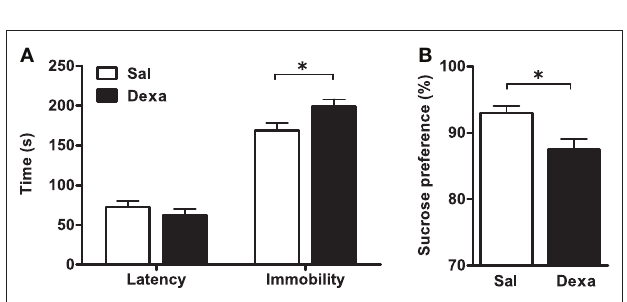
FIgure 2 | Prenatal administration of dexamethasone induces depressive-like behavior. (A) Latency to first immobility and duration of immobility in the forced swim test and (B) sucrose preference were assessed in Sal and Dexa rats. Each bar represents the mean + SEM from 16 to 17 rats per group. Data from SPT are representative from three independent